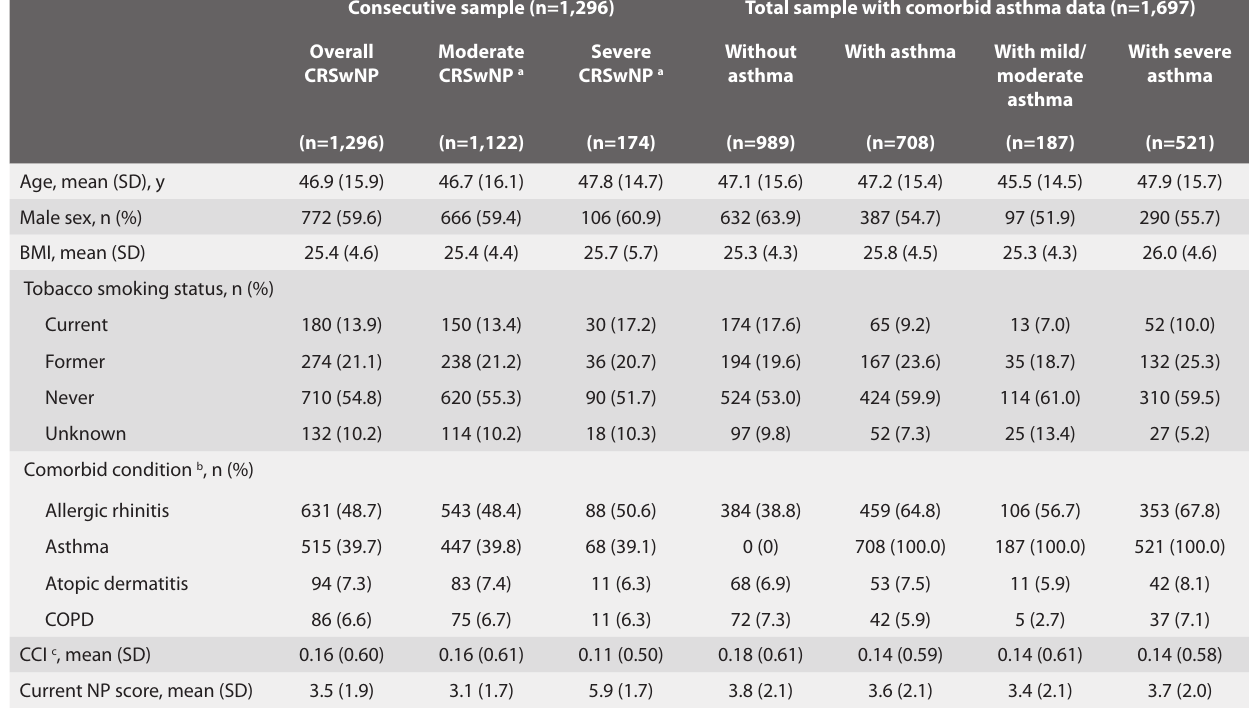
Table 1. Patient demographic and clinical characteristics at survey